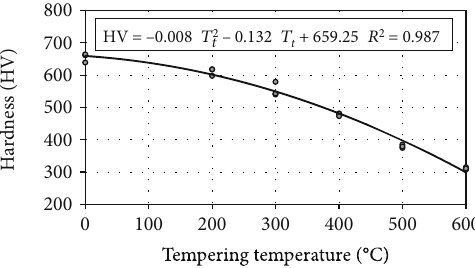
Figure 4: The e ff ect of tempering temperature ( T (HV) of a friction plate made of 41Cr4 steel (hardness was measured at three points at each